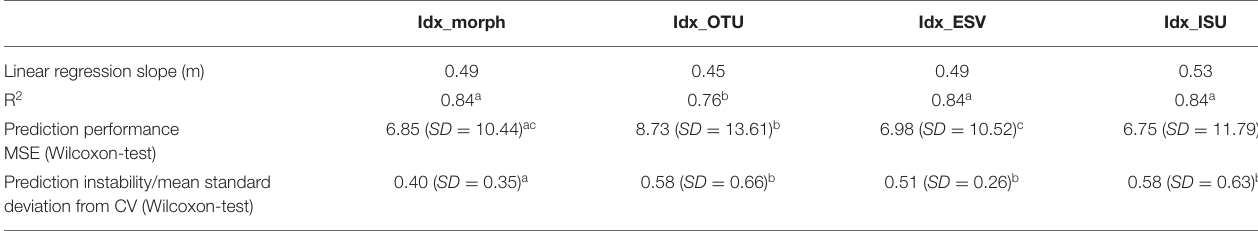
TABLE 2 | Summary table of the performances of the four